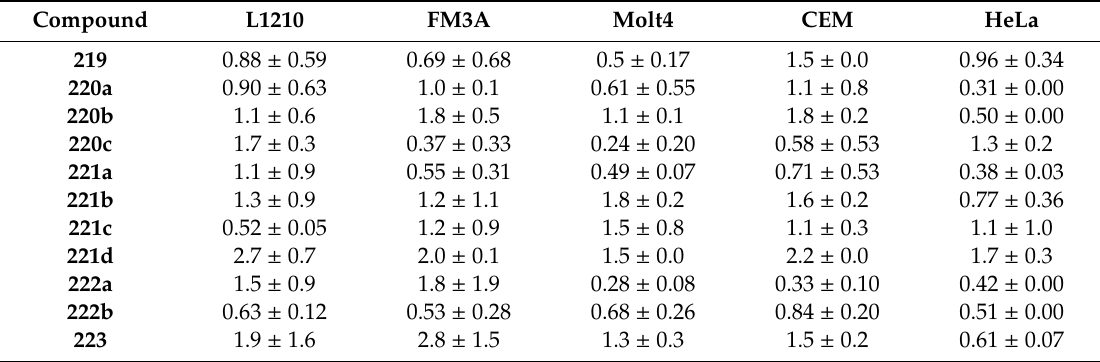
Table 32. In vitro inhibitory effects of compounds 219 – 223 on the proliferation of murine leukemia